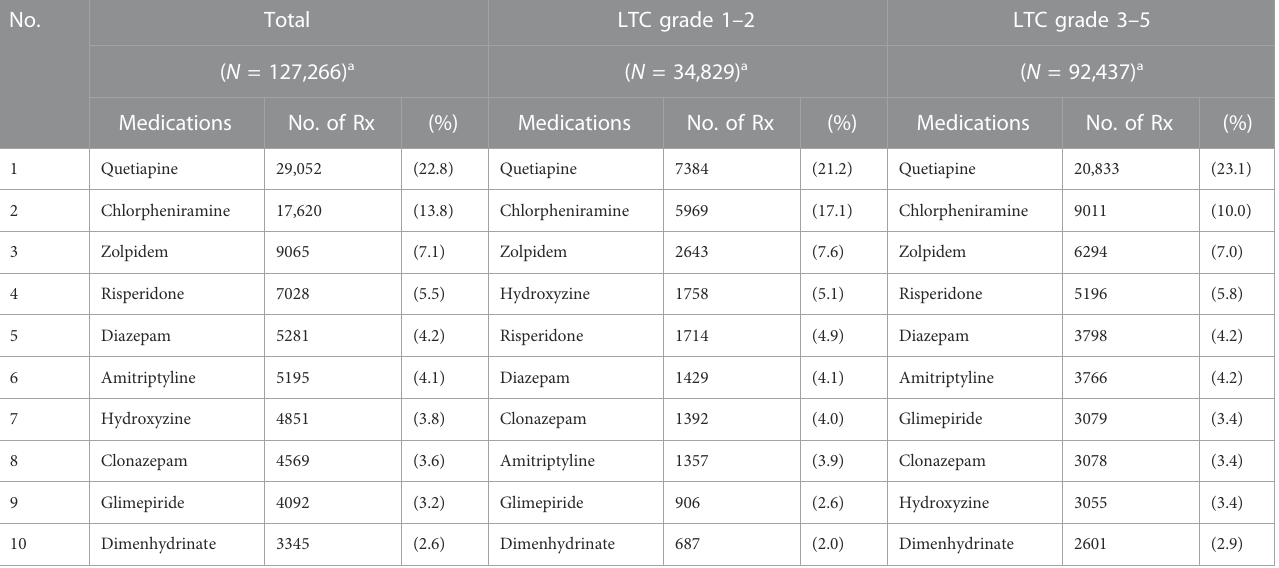
TABLE 3 Top 10 potentially inappropriate medications according to the LTC grade.